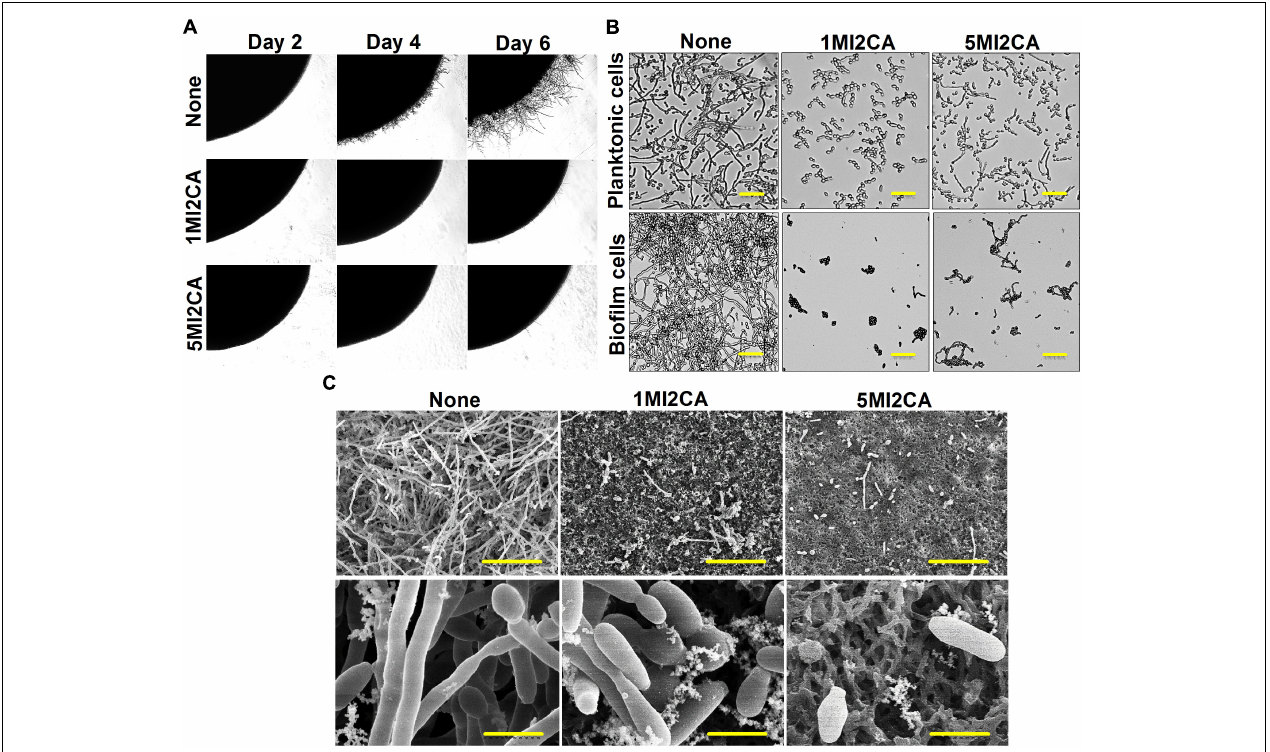
FIGURE 4 | Effects of 1MI2CA and 5MI2CA on C. albicans DAY185 morphology and hyphal growth. C. albicans morphology on solid media (A) . C. albicans was streaked on PDA agar plates supplemented with 10% fetal bovine serum in the absence or presence of 1MI2CA or 5MI2CA (0.1 mM). Colony morphologies were photographed every 2 days at 37 ◦ C. Inhibition of the hyphal growths of planktonic and biofilm cells of C. albicans (B) . C. albicans was grown in PDB medium in the absence or presence of 1MI2CA or 5MI2CA (0.1 mM) at 37 ◦ C. Cultures were sampled after 24 h and photographed under a bright field microscope. The scale bar represents 100 µ m. Microscopic observations (SEM) of the effects of the two methylindoles (0.1 mM) on biofilms and hyphal formation (C) . C. albicans cells were grown on nylon filter paper in the presence or absence of 1MI2CA or 5MI2CA and visualized by SEM. Scale bars represent 50 and 5 µ m, respectively. At least two independent experiments were conducted. None indicates untreated control cells.